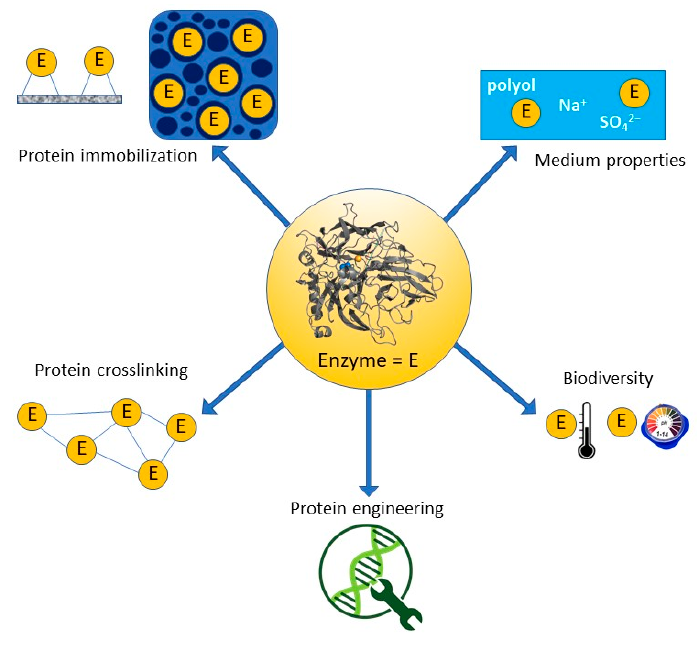
Figure 2. Strategies for all enzyme stabilization.